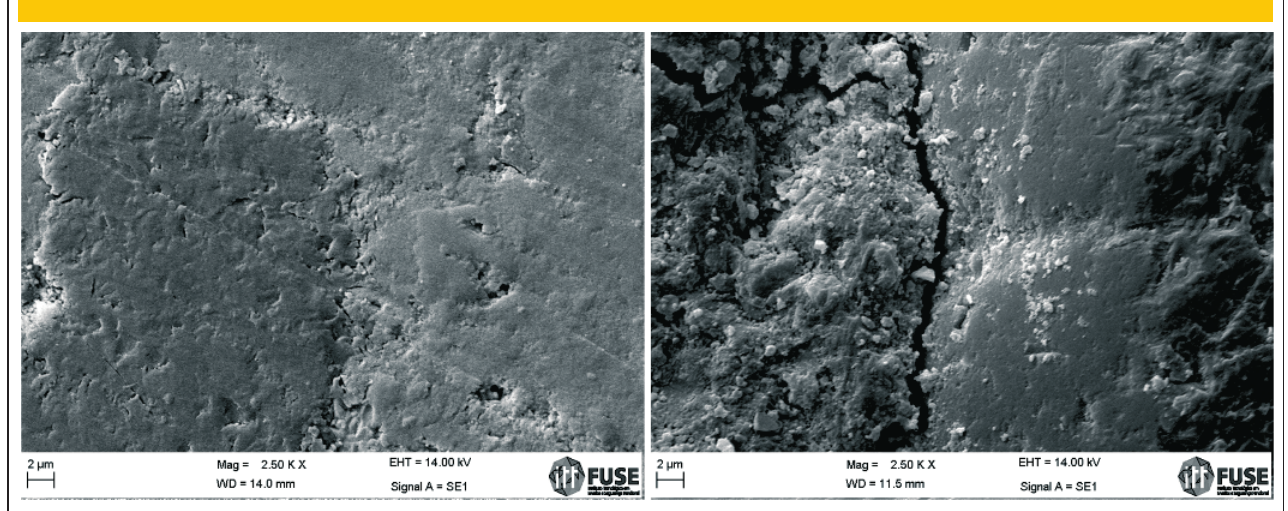
Figure 4 – SEM image of the cementitious material and natural aggregate (left) and of the old cementitious material and RCA (right) (2,500x